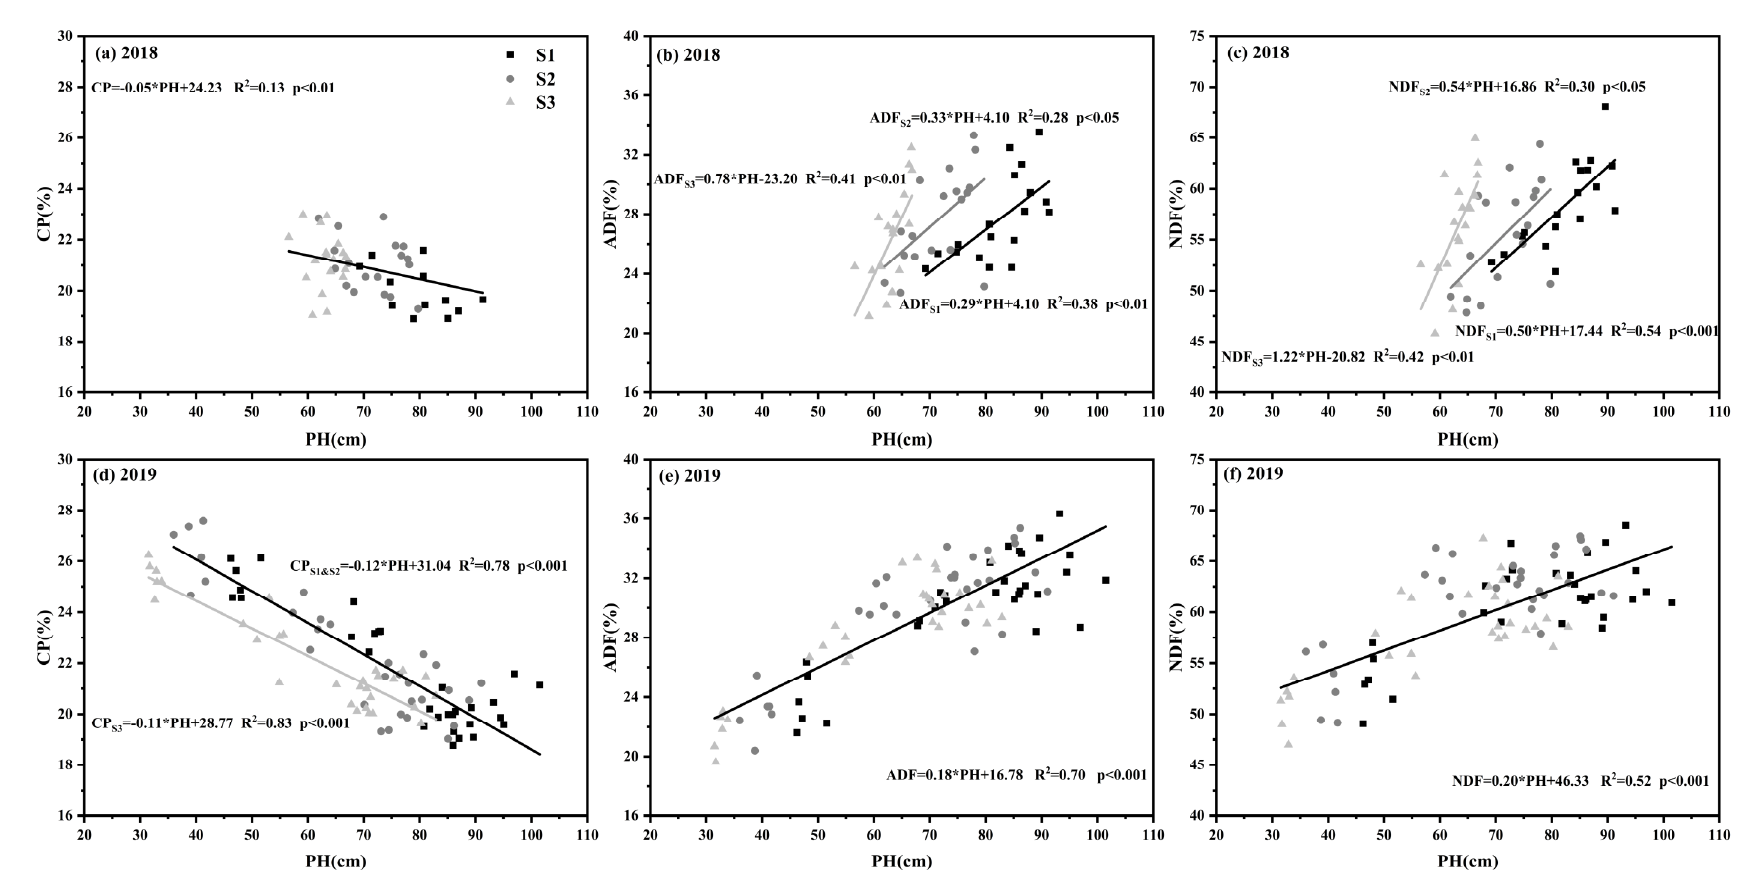
Figure 7. Linear regression between alfalfa plant height (PH) and quality parameters under different salinity treatments in 2018 ( a – c ) and 2019 ( d – f ). CP: crud protein; ADF: acid detergent fiber; NDF: neutral detergent fiber.